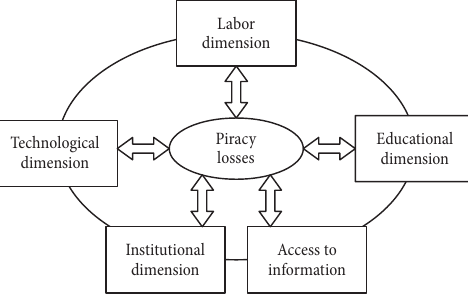
Fig. 1. Relationship between